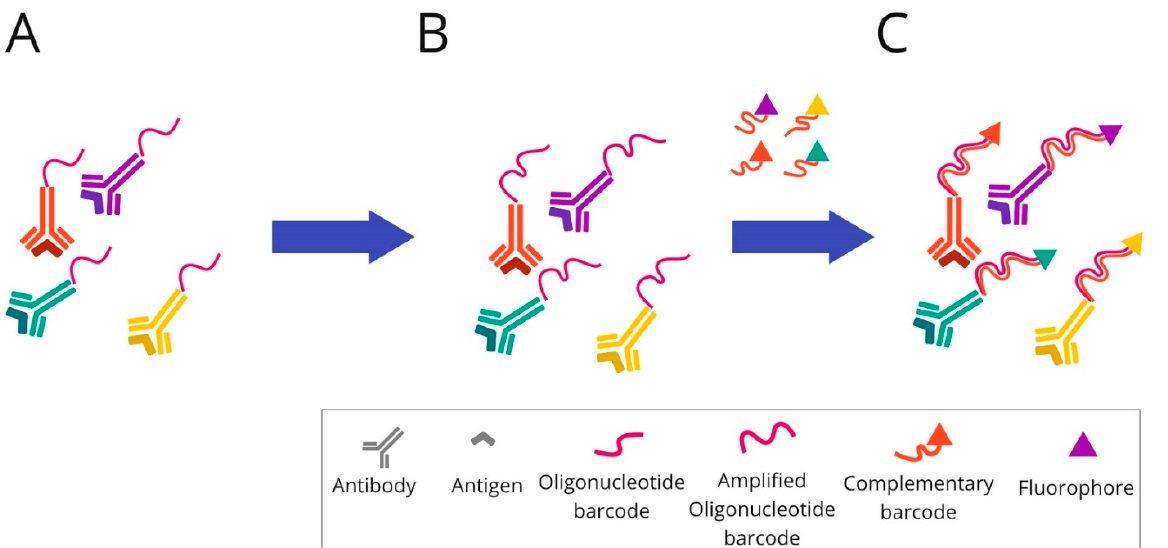
Figure 8. Overview of InSituPlex technique: ( A ) Mixture of target antibodies conjugated with unique oligonucleotide barcodes are used to stain a tissue section. ( B ) Then, the ratio of barcodes per antibody is increased on the tissue through a process that amplifies all targets simultaneously. ( C ) The fluorescently tagged probes complementary to each barcode are added to the sample to hybridise and label each target. Finally, the sections are ready for fluorescence imaging.